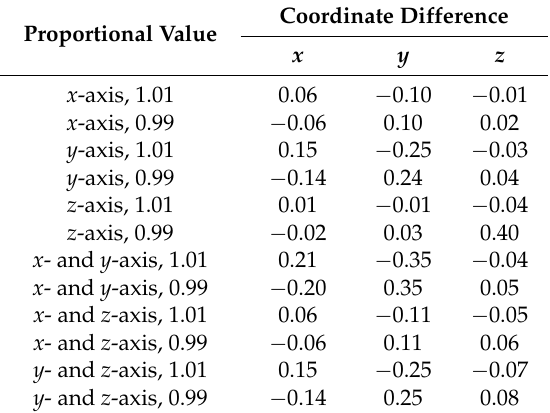
Table 3. Experiment results of proportional error simulation. (Unit: mm).